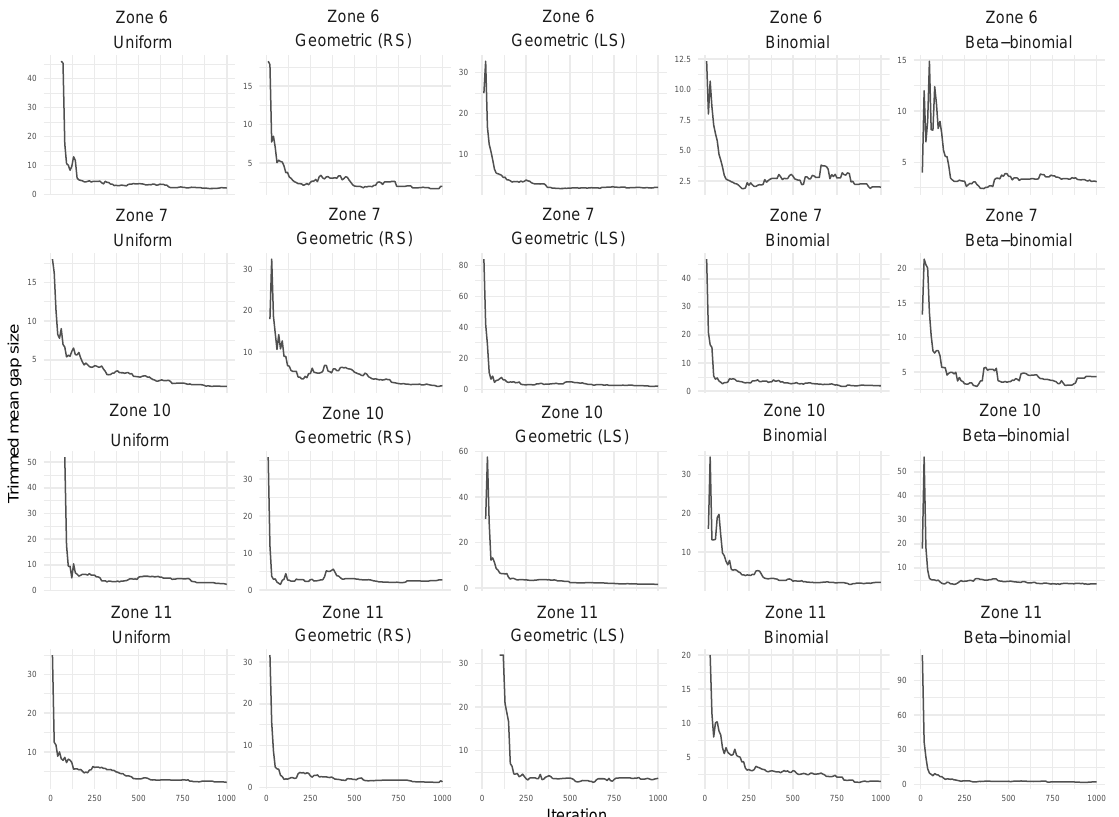
Figure 7. Time-dependent evolution of the trimmed mean gap size for the mesh assembly in the case of d = 2 and O / R = 5, when the dynamics of the system is frozen once the total number of rods in the structure reaches 1000. The evolution is spitted for each initial distribution of the rod lengths and each of the four central